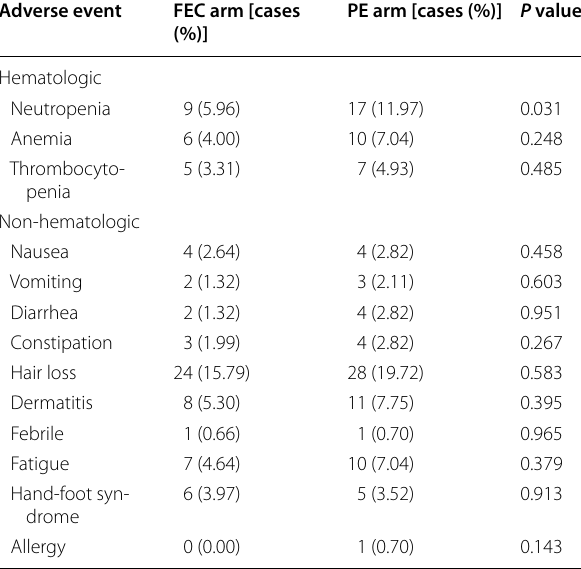
Table 6 Frequency of grade 3–4 adverse events in the FEC and PE